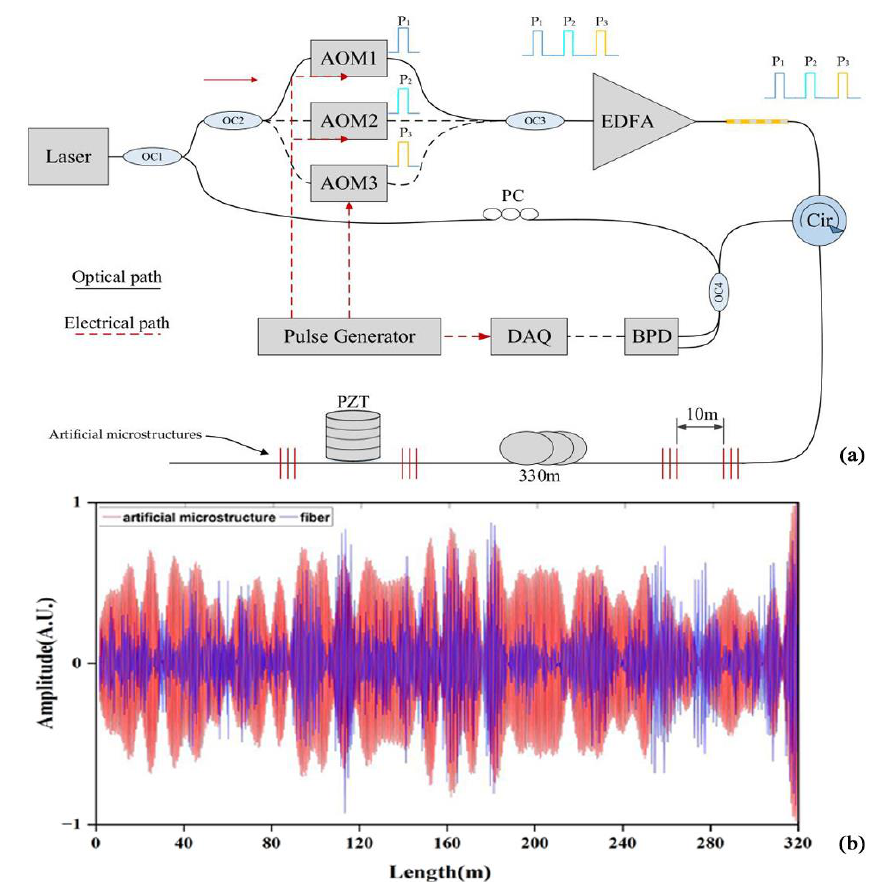
Figure 8. ( a ) Experimental setup. ( b ) The beat frequency signal [44].